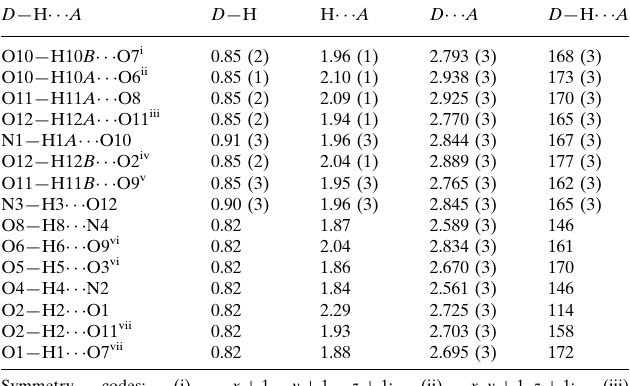
Hydrogen-bond geometry (A˚ , (cid:2)